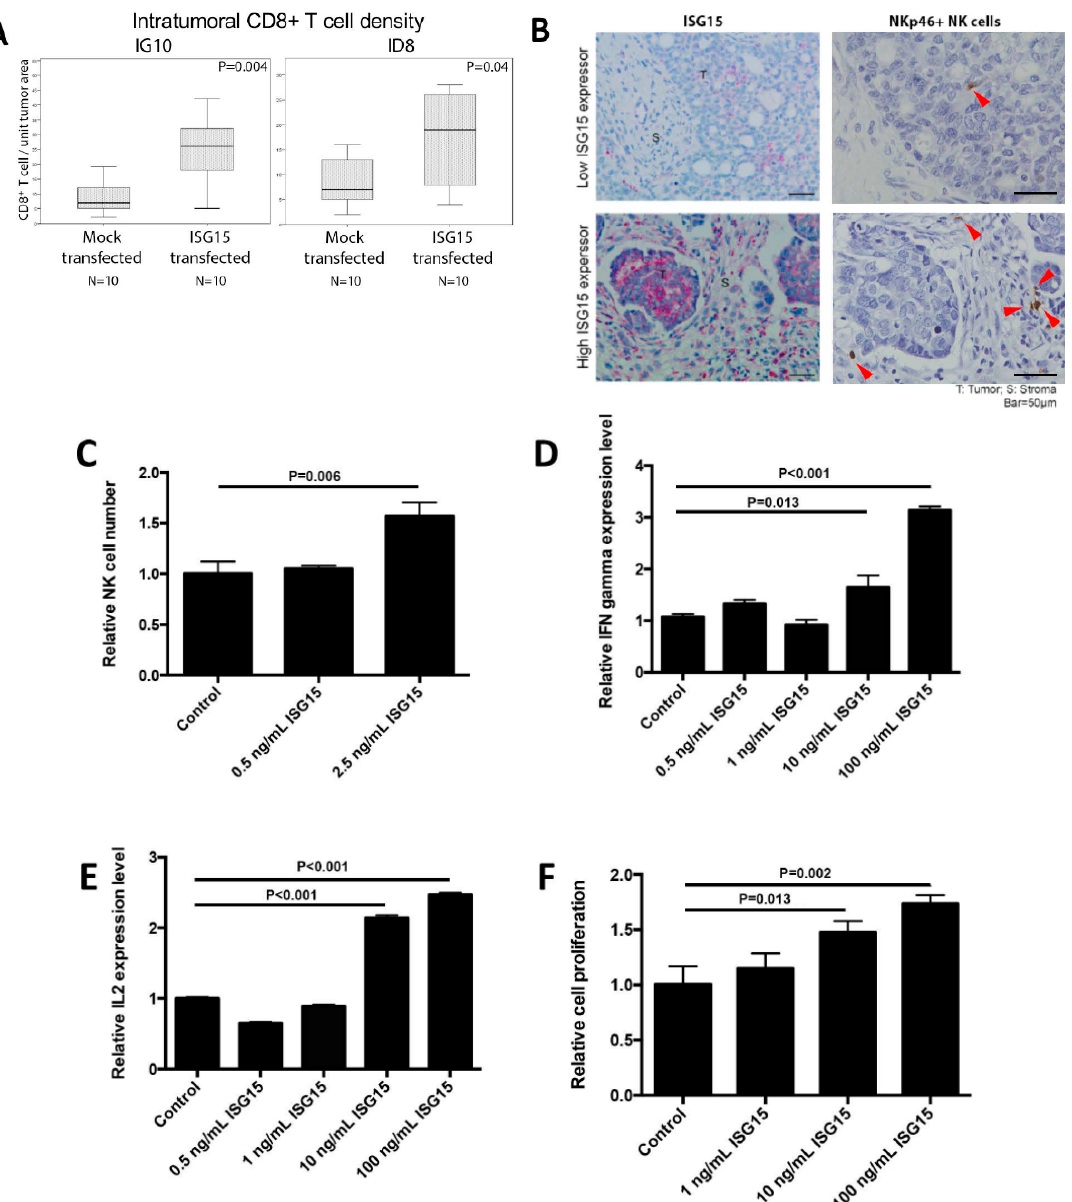
Figure 6. ISG15 activates CD8+ T cells via NK cell activation. ( A ) Immunolocalization of CD8+ T cells in tumor nodules isolated from C57BL/6 immune-competent mice injected with ID8 or IG10 cancer cells showed a significant increase in intraepithelial CD8+ T cells in tumors developed from mice injected with ID8 or IG10 transfected with ISG15 compared to those with the mock construct. ( B ) Immunostaining result showed a positive correlation between ISG15 expression in ovarian cancer cells and CD335 (NKp46) positive NK cell densities in ovarian tumor tissues (Bar = 50 µ m). For the experiments performed to determine whether ISG15 could activate NK cells, experimental results showed that recombinant ISG15 significantly increased ( C ) NK cell proliferation, ( D ) IL-2 and ( E ) IFN- γ production in a dosage response manner. ( F ) To determine whether ISG15 treated NK cells could activate CD8+ T cells, conditioned media collected from NK cells treated with ISG15 were used to culture CD8+ T cells. CD8+ T cells treated with conditioned media from ISG15 treated NK cells showed a significant increase in cell number in a dosage response manner when compared to CD8+ T cells treated with conditioned media from NK cells treated with the control PBS.